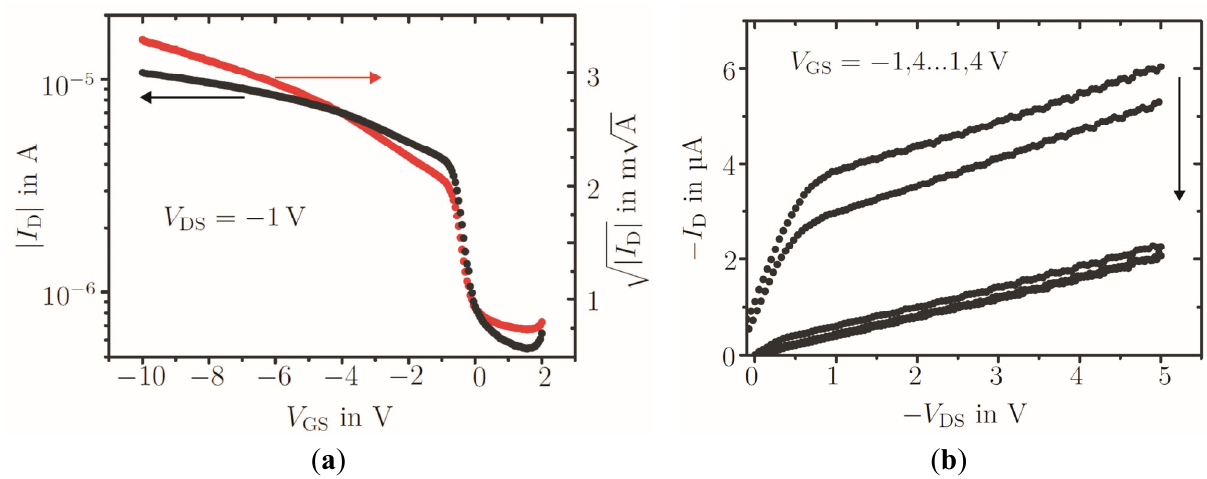
Figure 10. ( a ) Transfer and ( b ) output characteristics of an inverted coplanar single particle TFT integrated by SWEB technique using Si nanoparticles (L = 60 nm, W = 100 µm and t ox = 15 nm). © 2015 IEEE. Reprinted, with permission, from [3].